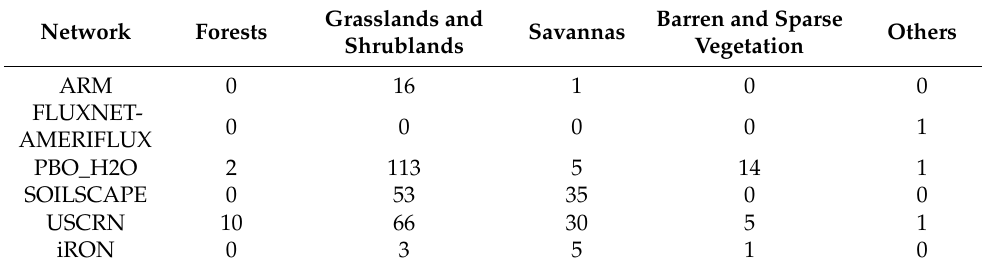
Table 2. Number of stations with different land cover types over observation networks. Network Forests